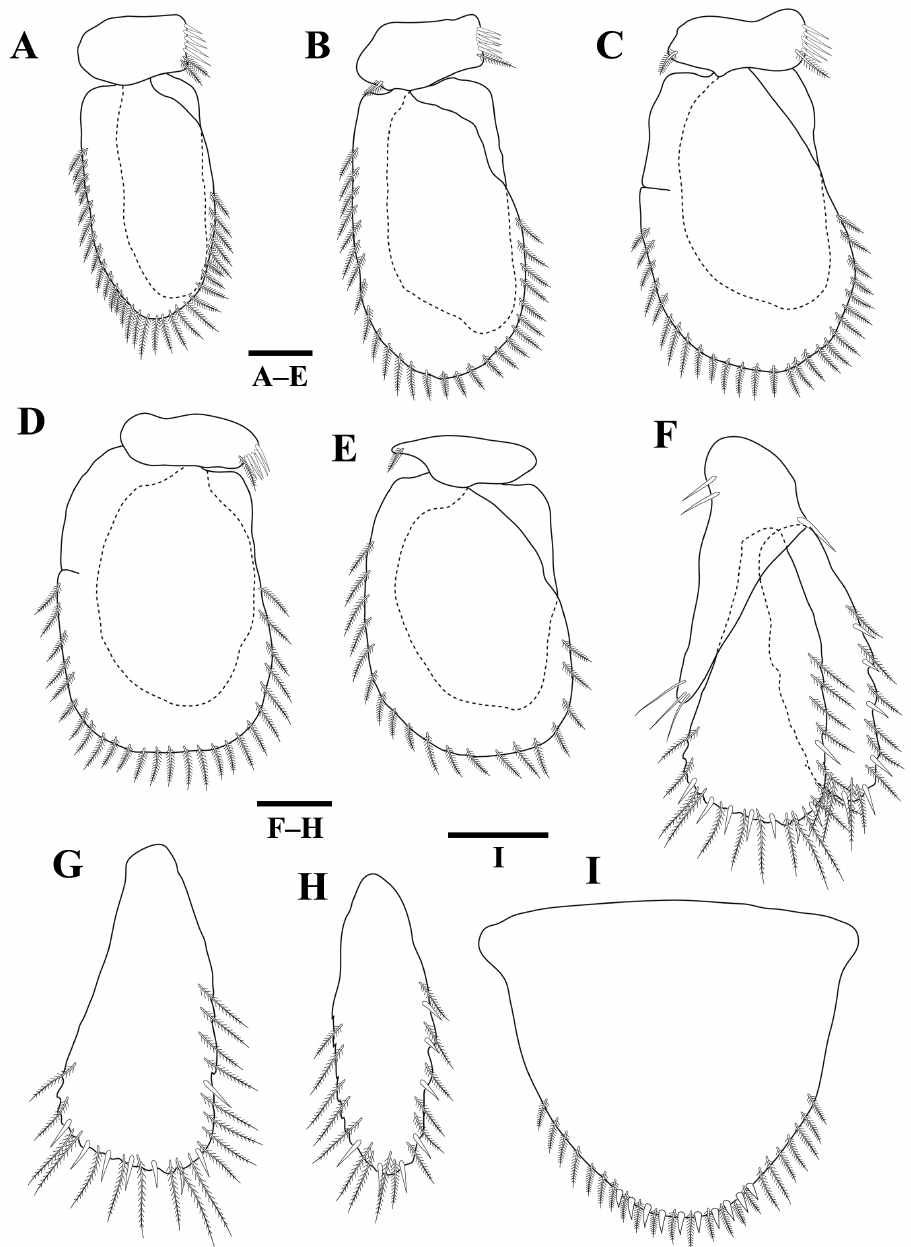
Figure 7. Tachaea koreaensis sp. n., female holotype. A pleopod 1 B pleopod 2 C pleopod 3 D pleopod 4 E pleopod 5 F uropod G uropod endopod H uropod exopod I pleotelson. Scale bars: 0.2 mm ( A–H ), 0.4 mm ( I